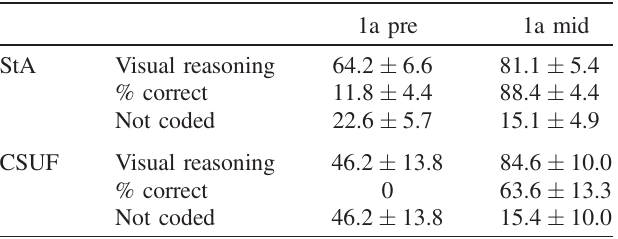
TABLE II. The percentage of pre- and midtest responses to question 1a that were coded as visual, and the percentage of correct reasoning of these responses (e.g., 11.8% of the St Andrews visual responses to pretest question 1a were correct). The responses are shown for StA ( N ¼ 53 ) and CSUF ( N ¼ 13 ) students separately. Also included are the percentage of answers that were not coded. Responses that included both mathematical and visual reasoning are included as visual reasoning in the table. Errors are the standard errors of a